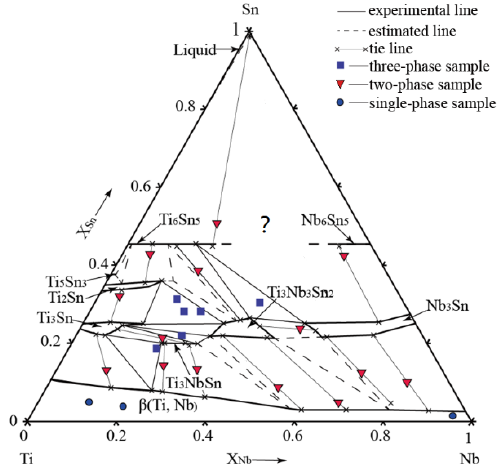
Figure 4. Isothermal section of Ti-Nb-Sn ternary system at 1173 K.